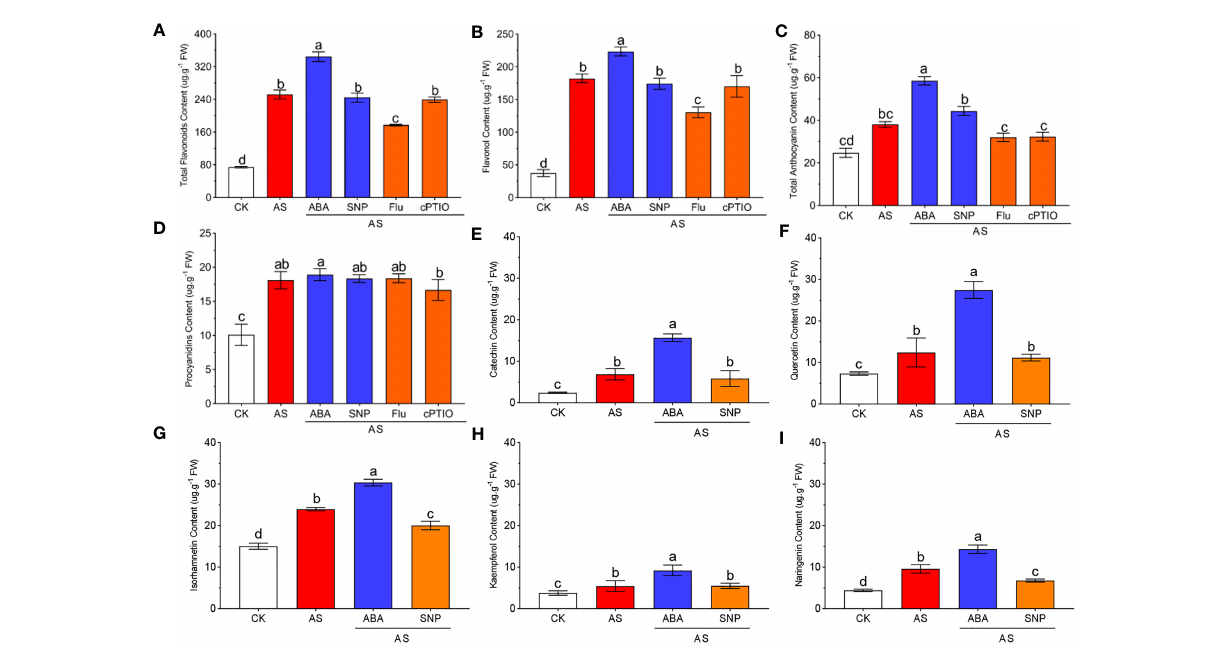
FIGURE 7 ABA and SNP promote the accumulation of fl avonoid and anthocyanin secondary metabolites under alkaline stress. 40-day-old seedlings were treated with different treatments (100 mM alkali, 100 mM alkali +15 m m ABA/5 m m Flu, 100 mM alkali +50 m m SNP/70 m m cPTIO) for 12 days (AS : NaHCO 3 : Na 2 CO 3 = 9:1, pH=9.5). Plants grew in Hoagland solution served as controls(CK). (A) : Total fl avonoid content; (B) : Flavanol content; (C) : Total anthocyanin content; (D) : Proanthocyanidin content; (E) : Catechin content; (F) : Quercetin content; (G) : Isoamnetin rhcontent; (H) : Kaempferol content; (I) : Naringenin content. Bars represent the means ± SDs of three replicates. Signi fi cant differences among treatments are indicated by different letters within a panel based on Duncan ’ s multiple range test ( P < 0.05).